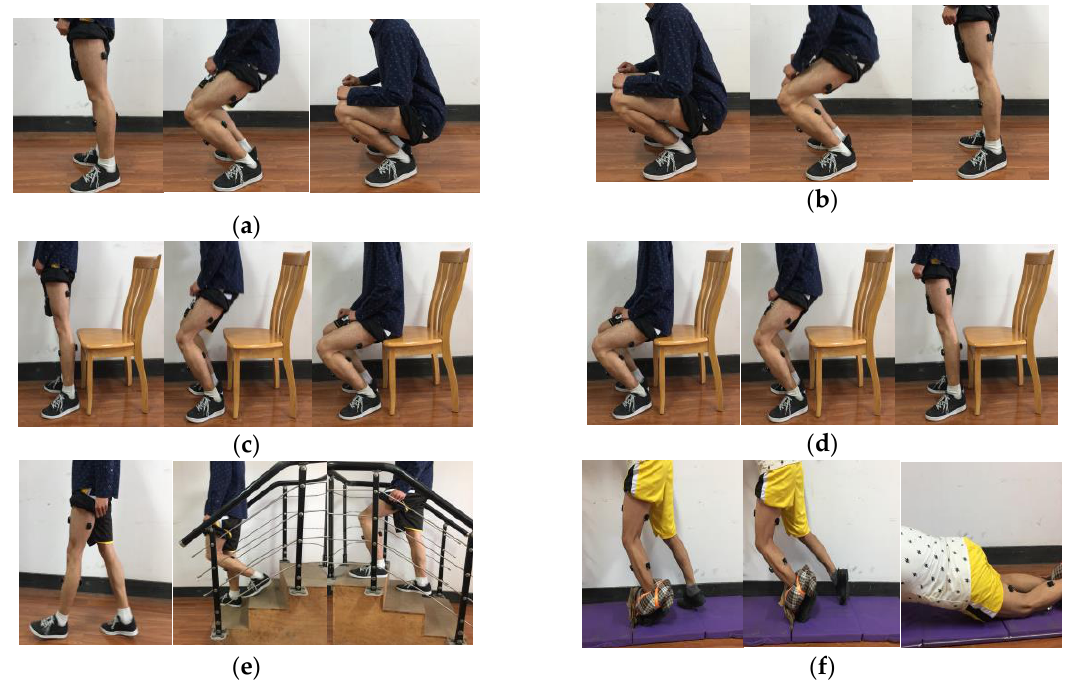
Figure 2. Seven activities of daily living and trip-fall in the experiment. ( a ) stand-to-squat; ( b ) squat-to-stand; ( c ) stand-to-sit ; ( d ) sit-to-stand; ( e ) walking, stair-ascending and stair-descending; ( f ) trip-fall .